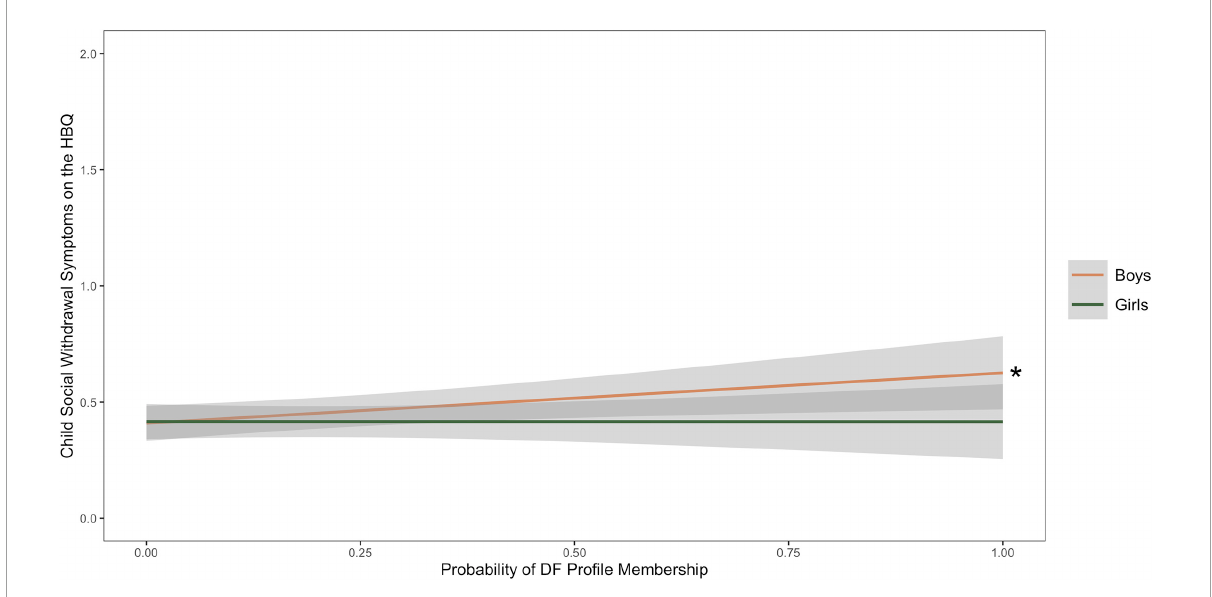
FIGURE3 Line graph depicting associations between the probability of dysregulated fear (DF) profile membership and parental report of social withdrawal symptoms on the Health and Behavior Questionnaire (HBQ), with child sex as a moderator. Other multiple regressions with probability of profile membership, child sex, and their interaction as predictors of maternal report of child social withdrawal on the Health and Behavior Questionnaire (HBQ), with cohort as a covariate were not significant ( R 2 = 0.01, f 2 = 0.01). The symbol ∗ indicates a significant slope ( p <